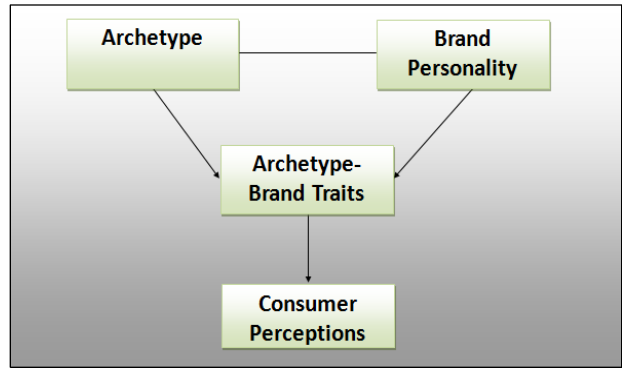
Figure 2. Research framework.